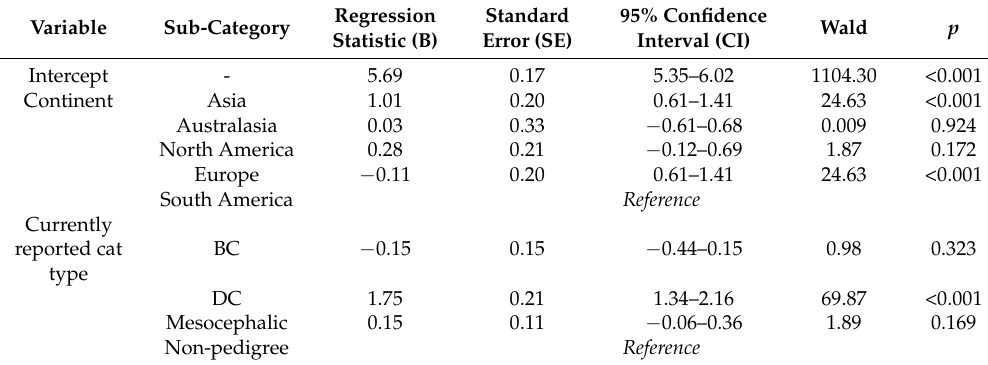
Table 5. Generalized estimating equation of variables that predict the ratings of cats considered to be brachycephalic ( n = 4/15 cat images as per Table 1). The group included cats considered to be mildly, moderately or extremely dolichocephalic as scored by a panel of veterinarians ( n = 50; see Table 1). Analyses were conducted taking owner and cat identification into account as repeated measures. “Reference” is the sub-category against which those within the same variable were compared. Currently reported cat type was designated to one of four categories (brachycephalic (BC), mesocephalic, dolichocephalic (DC) or non-pedigree) based on reported breed of the respondent’s oldest owned